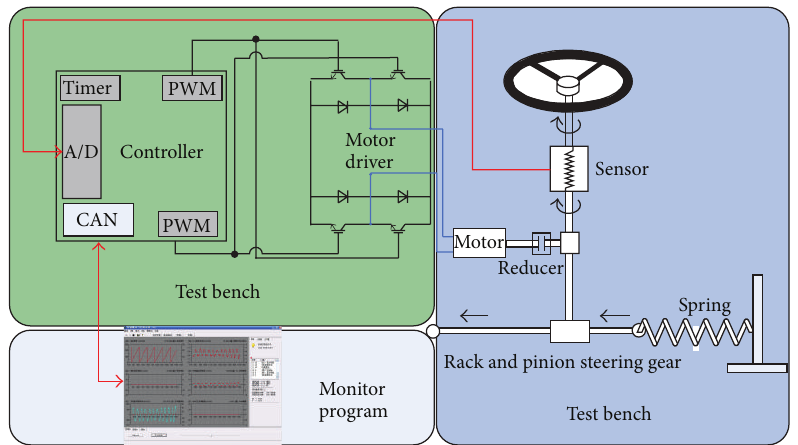
Figure 1: Overall view of the developed test